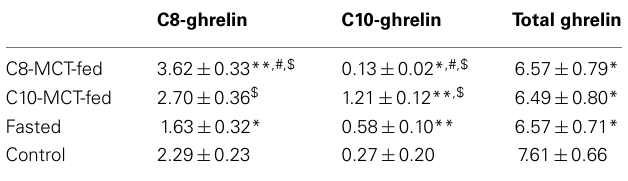
Table 2 | Stomach contents of C8- or C10-ghrelin under different nutritional conditions.